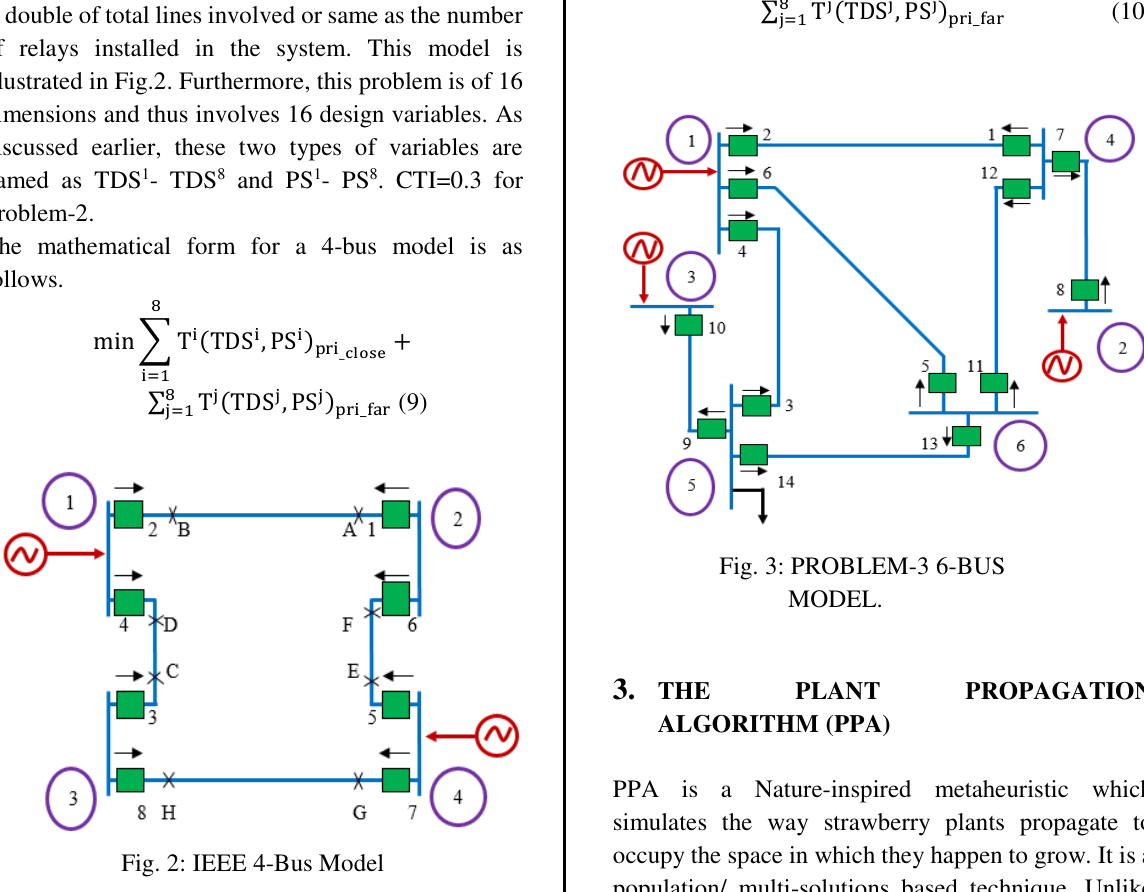
Fig. 2: IEEE 4-Bus Model